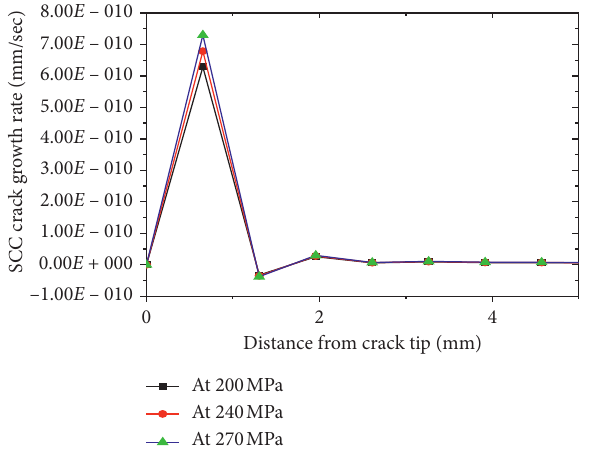
Figure 12: SCC crack growth rate (mm/cycle) vs. distance from crack tip.